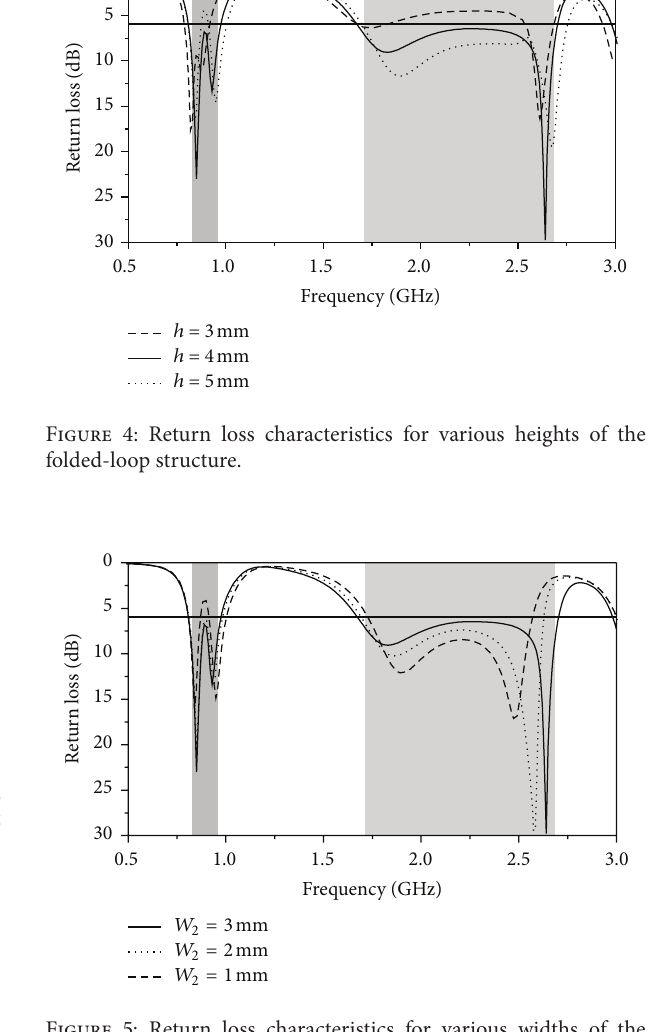
Figure 5: Return loss characteristics for various widths of the folded-loop structure.